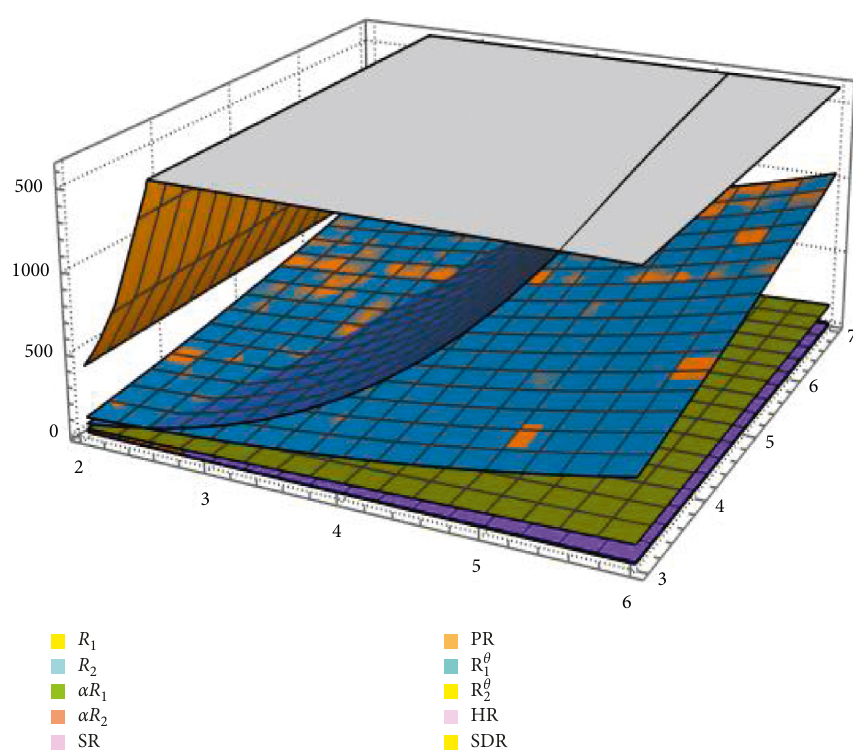
Figure 4: Comparison of topological indices.